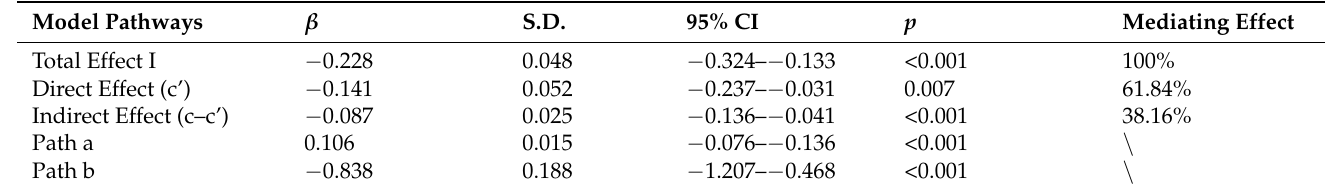
Table 5. Mediation analysis